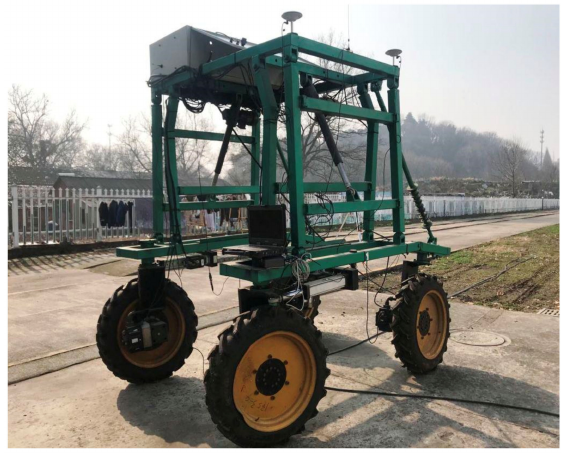
Figure 12. Electric vehicle testing platform in the field.